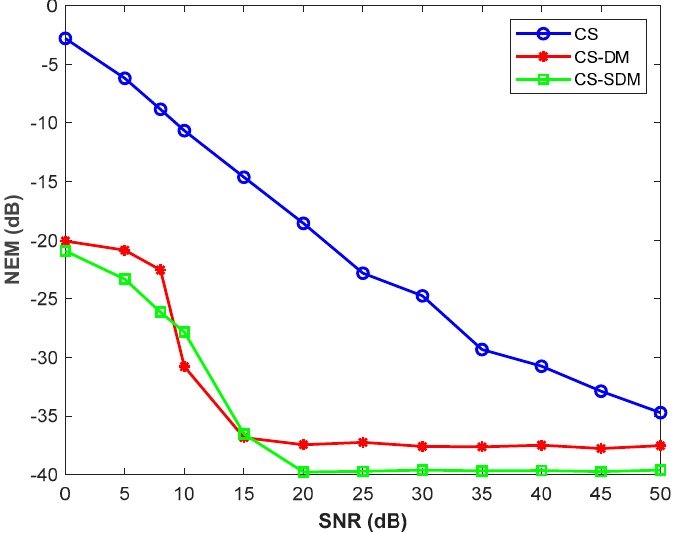
Figure 15. Localization NEM versus SNR for the three localization systems. T max = 3, standard deviation of TOA measurement noise SD1 = 5 ns. Results are averaged over 15